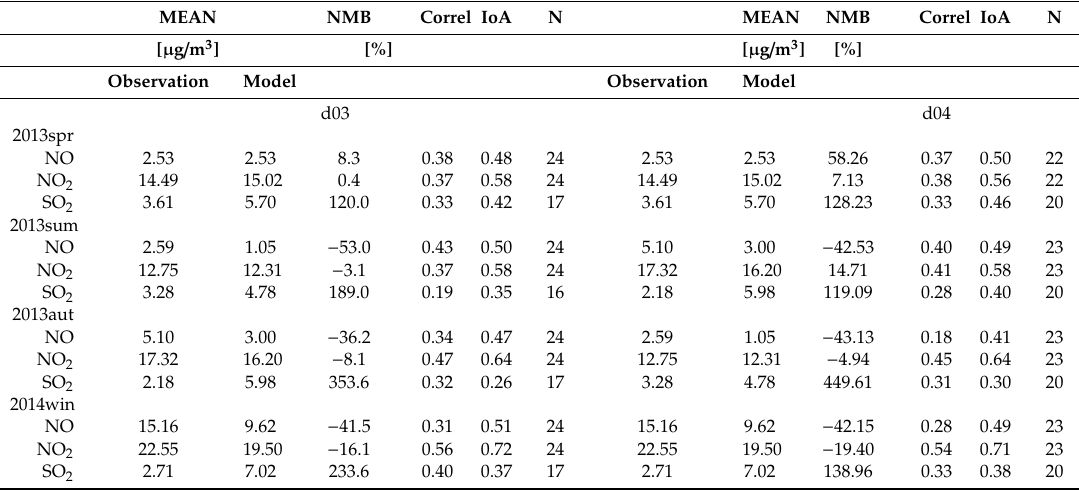
Figure 7. Spatial averages of observed and simulated hourly concentrations for ( a ) NO, ( b ) NO 2 , and ( c ) SO 2 from di ff erent AAPMSs within d04 over the four seasons. Table 3. Observed and simulated averaged concentrations 1 and ensemble performances 2 of the participant CTMs for hourly concentrations of NO, NO 2 , and SO 2 at each AAPMS in each season. MEAN NMB Correl IoA